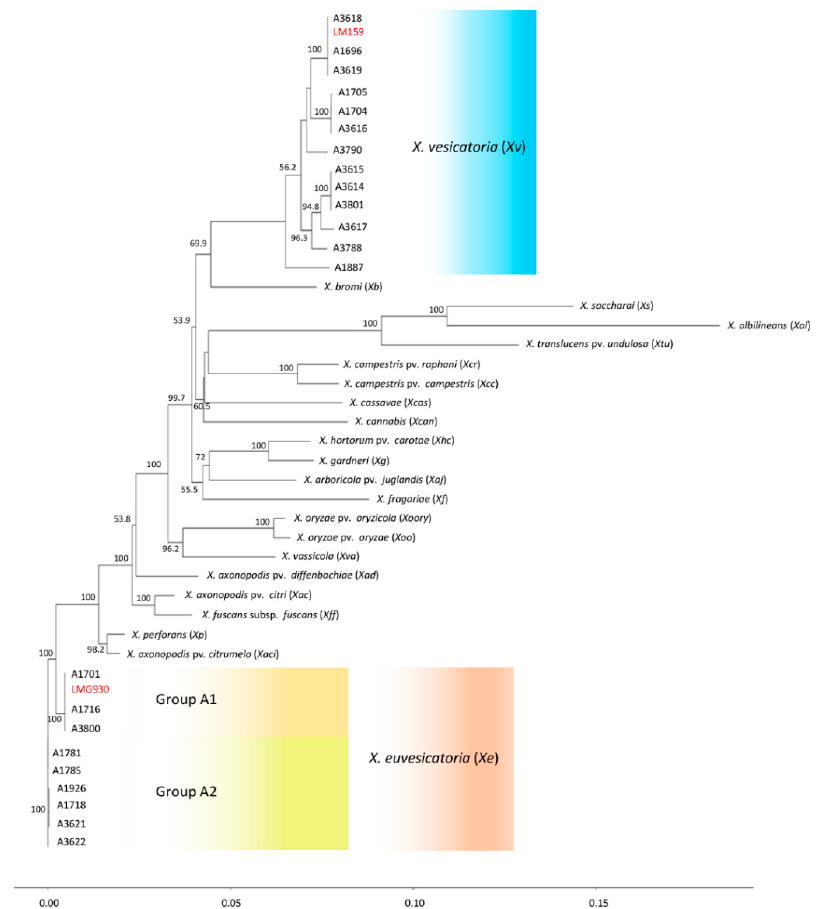
Figure 2. Phylogenetic position of Xanthomonas euvesicatoria , X. vesicatoria , and nineteen other plant pathogenic xanthomonads relative to each other. The phylogenetic tree was obtained using concatenated gene sequences for chromosomal replication initiator factor ( dnaA ), type I glyceraldehyde-3-phosphate dehydrogenase ( gapA ), DNA topoisomerase (ATP-hydrolyzing) subunit B ( gyrB ), hydroxymethylbilane synthase ( hmbs ), and pyruvate dehydrogenase ( pdg ) genes. Numbers on the nodes represent bootstrap values and are presented as percentage of 1000 replicates. The scale bar at the bottom shows the distance between strains of other species and strains of X. euvesicatoria and X. vesicatoria sequenced in this study. Sequences for other Xanthomonas species were extracted from the genomes listed in Table 3. LM159 and LMG930 are reference strains for X. vesicatoria and X. euvesicatoria , respectively.